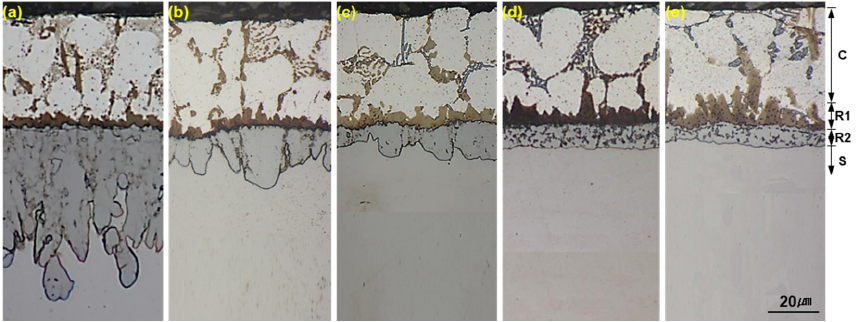
Figure. 1. Cross ‐ sectional optical micrographs of specimens hot dipped at 690 °C for 120 s. Figure 1. Cross-sectional optical micrographs of specimens hot dipped at 690 ◦ C for 120 s. The amount of Si added in the Al–7Ni wt % coating is varied as: ( a ) 0 wt % Si; ( b ) 1 wt % Si; ( c ) 2 wt %